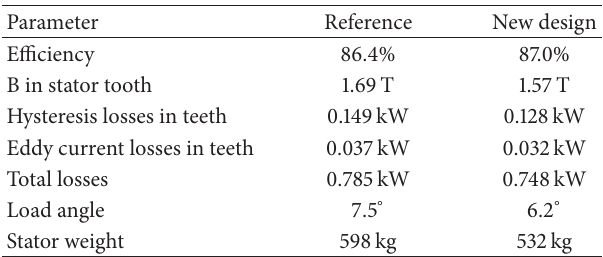
Figure 1: The geometry used in the FE model of the reference machine.